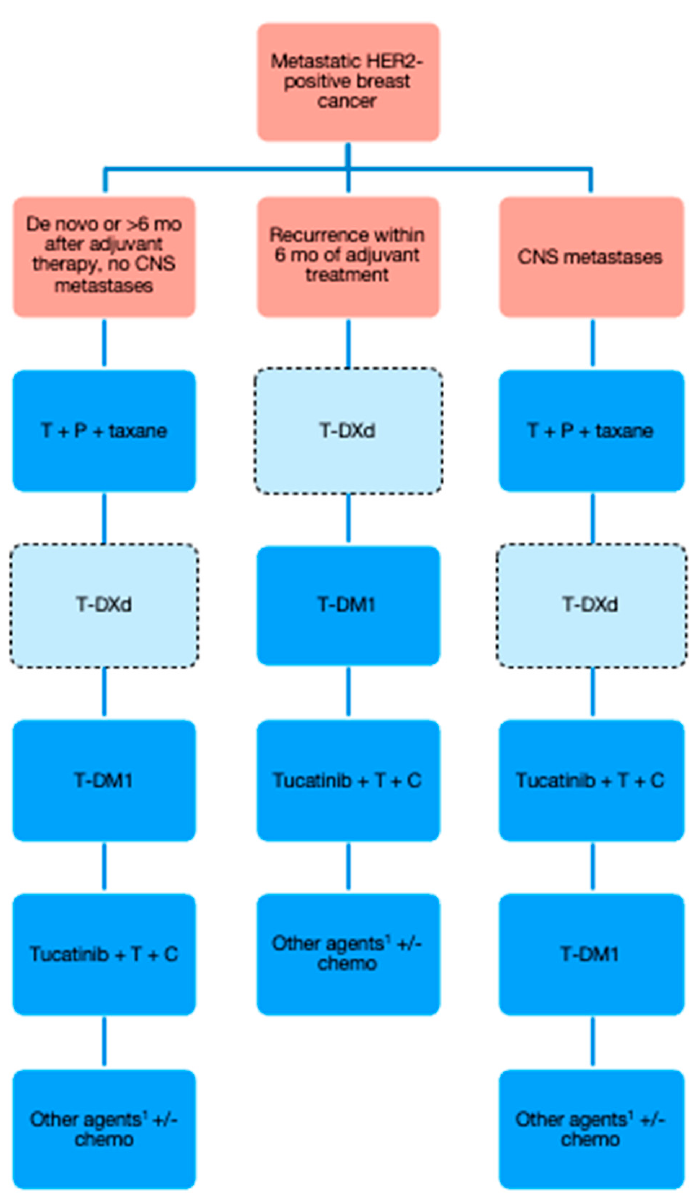
Figure 1. Proposed algorithm for publicly funded treatment of HER2-positive metastatic breast cancer in Canada. CNS = central nervous system; T = trastuzumab; P = pertuzumab; T-DXd = trastuzumab deruxtecan; T-DM1 = trastuzumab emtansine; C = capecitabine. 1 Clinical trials should always be considered at this stage as well.